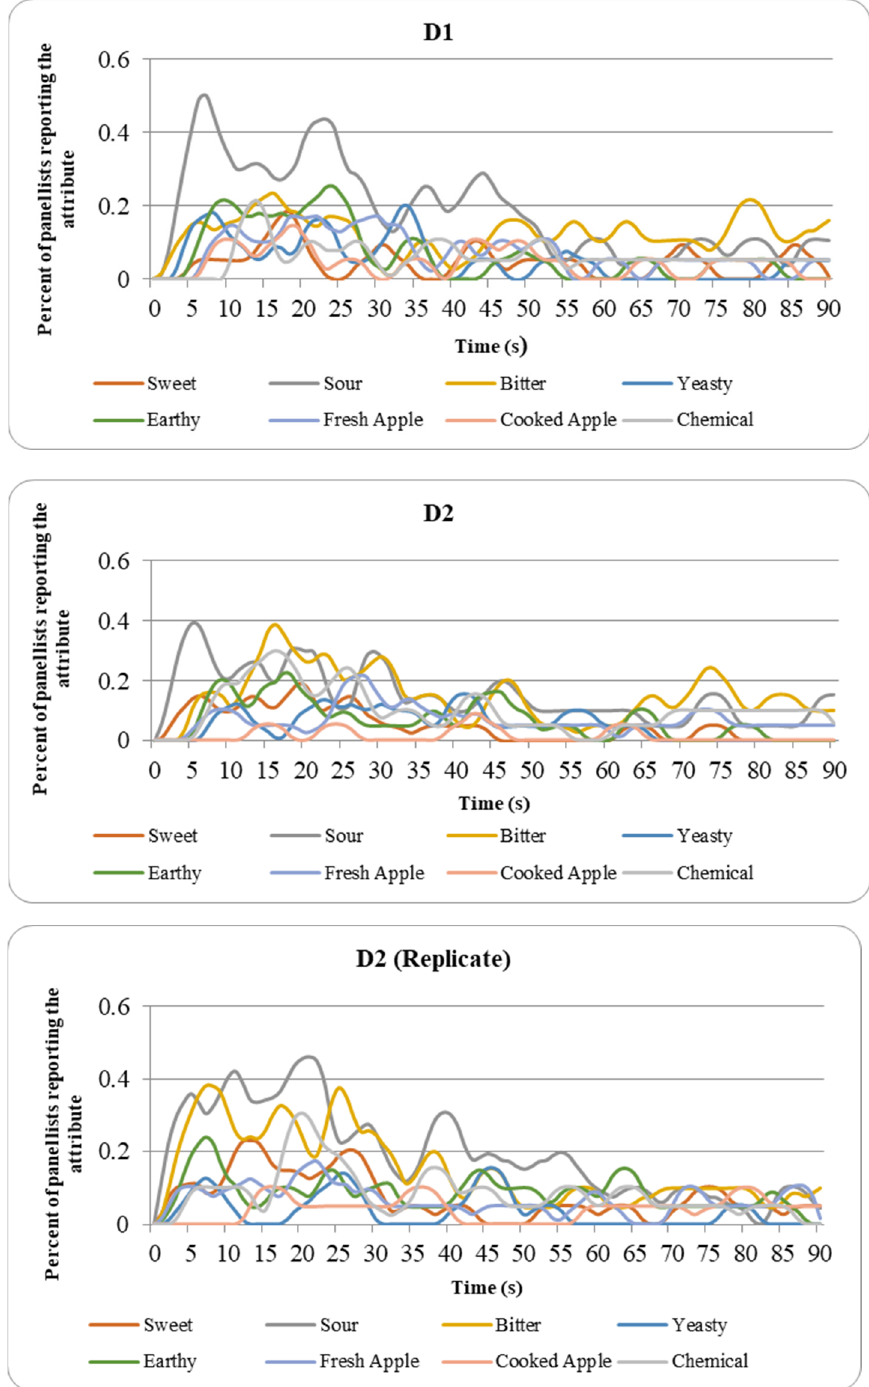
Figure 2. Temporal check-all-that-apply of the sweet ciders. The average proportion of citations of the attributes included in the TCATA task are outlined in Table 3. The dry ciders (D1 and D2) were found to be significantly higher in bitterness than the S2 and S3, in agreement with the category scales ( p < 0.05; Table 2). However, the average proportion of citations for the bitterness of S1 was not significantly different from the dry ciders (D1 and D2; p < 0.05). S1 was also found to be significantly higher in citations for sourness than the other sweet ciders (S2 and S3; p < 0.05). As ex- pected, the sweet ciders had a significantly higher proportion of citations for sweetness than the dry ciders ( p < 0.05). S1 also had a significantly higher citation proportion of the yeasty attribute than the other ciders ( p < 0.05). In agreement with the category scales (Ta- ble 2), D2 had a higher proportion of citations for the chemical attribute than all other ciders ( p < 0.05). The replicated cider sample’s average proportion of citations was not significantly different for any of the attributes ( p < 0.05), indicating that the experienced panellists were consistent. There were no significant differences in the average propor- tions of citations for the cooked apple, earthy, and fresh apple for the ciders, and as stated above, this may be because the experienced panellists were asked to select the attributes in the TCATA task. Table 3. The average proportion of experienced panellists' citations of the TCATA sensory attributes. Sample 0.037 b 1 Means in the same column, with the same letter, are not significantly different at α = 0.05. Experienced panellists were used in this study to evaluate the ciders; however, they were not experienced with the TCATA. Rather they had experience with trained panels on alcoholic beverages, as well as projective mapping and consumer acceptability trials. Looking at the D2 replicate (Figure 2), the results in Table 3, and the TCATA difference curve (not pictured as they were very few differences), it appears that their experience with sensory methodology helped the experienced panellists create reproducible results when evaluating the same cider twice. However, as shown in Figures 1 and 2, none of the proportions of citations were above 0.8. To increase the consistency of the results, many